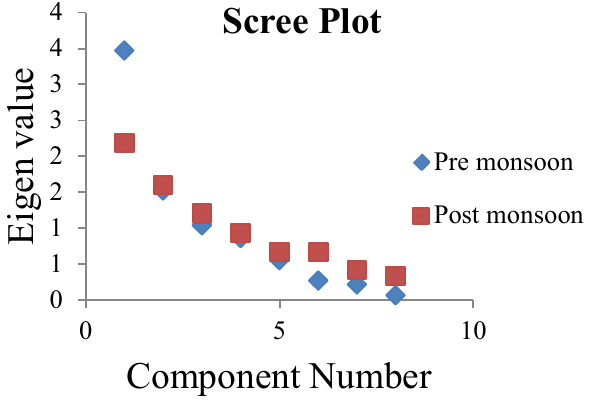
Fig. 10 Scree plot of the component in PCA for pre-monsoon and post-monsoon